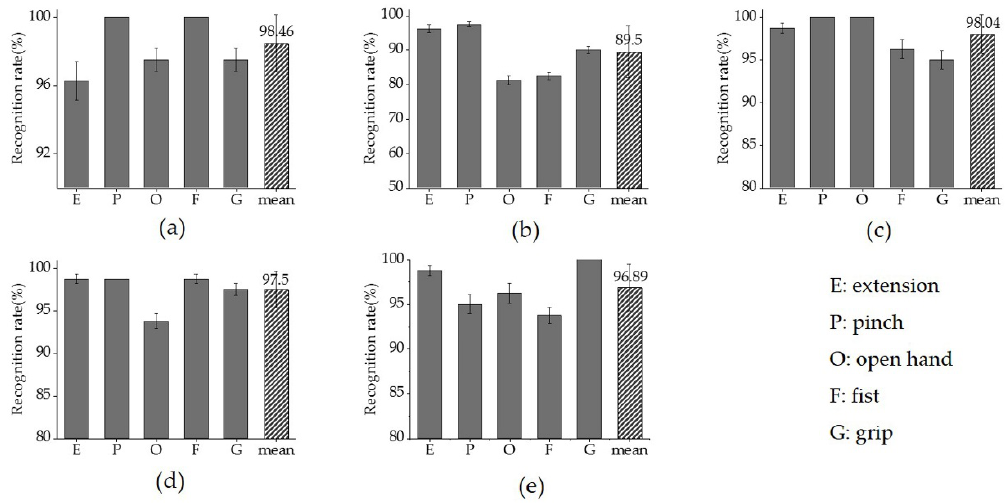
Figure 8. The gesture recognition rate results, with ( a ), ( b ), ( c ), ( d ), and ( e ) representing one individual participant each. The extracted feature data was divided into a training set and a test set at the ratio of 4:1 and the recognition rate of each gesture (solid) was calculated through a support vector machine (SVM) classifier with 5-fold cross-validation. The mean recognition rates (shadow) for every participant were also calculated.